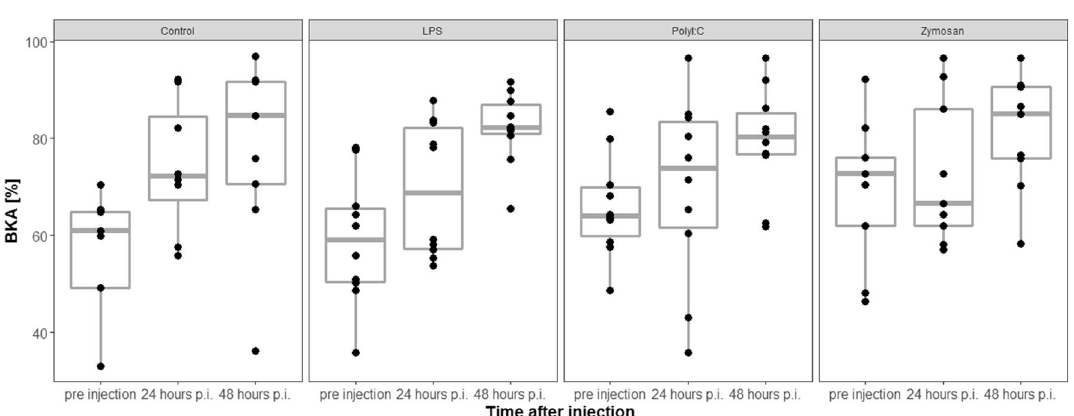
Figure 3. BKA (%) change was not affected by antigen type. p.i. = post injection. The figures show medians (bold line), 25–75% percentiles (box), maxima and minima (whiskers) and data points (dots).